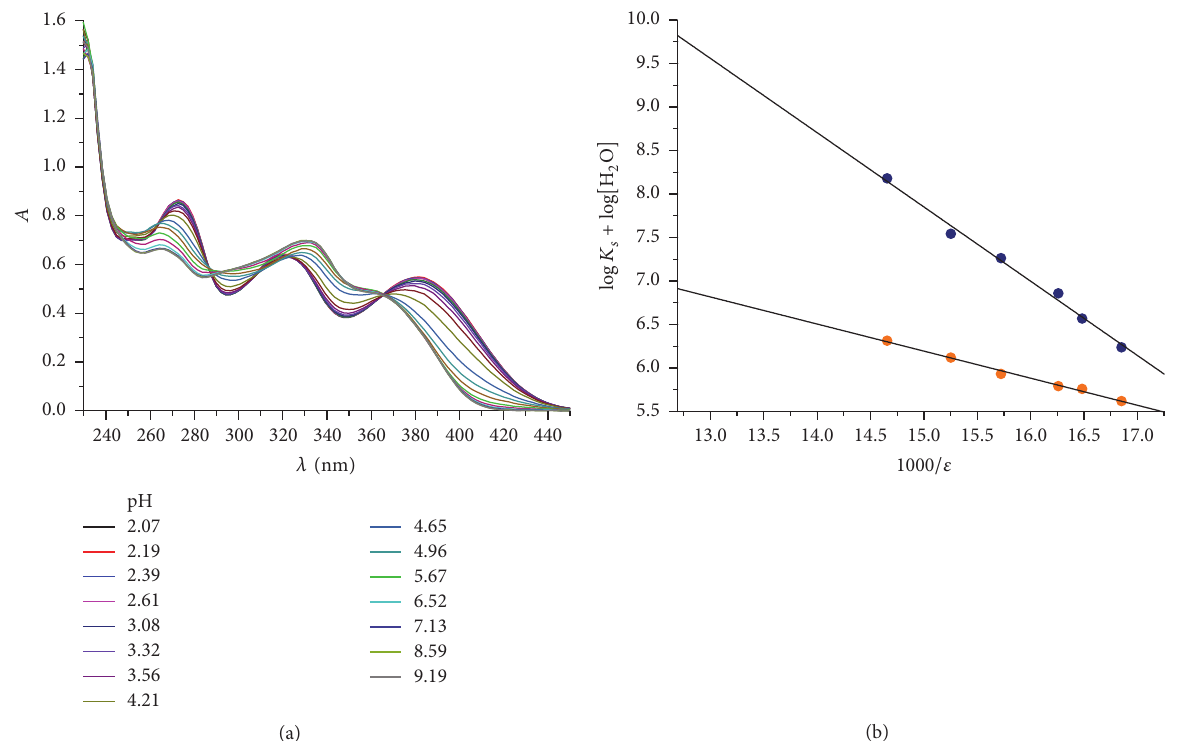
Figure 2: Determination of protonation constants of LAP by (a) UV/pH titration of LAP in 43/57 (w/w%) methanol/water mixture and (b) Yasuda-Shedlovsky extrapolation.